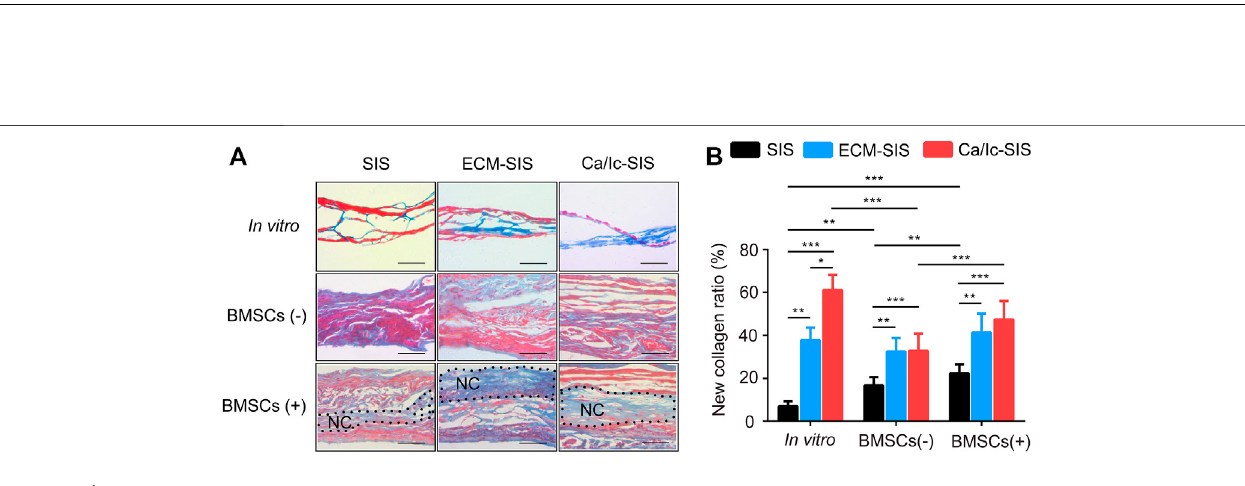
Frontiers in Bioengineering and Biotechnology |